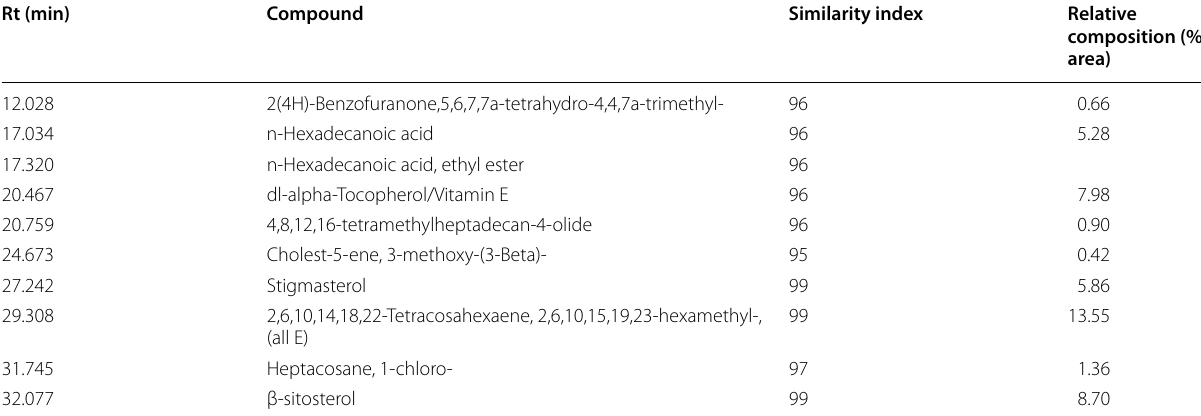
Table 4 Characterized chemical constituents of the n-hexane extract of leaves of I. trichantha Rt